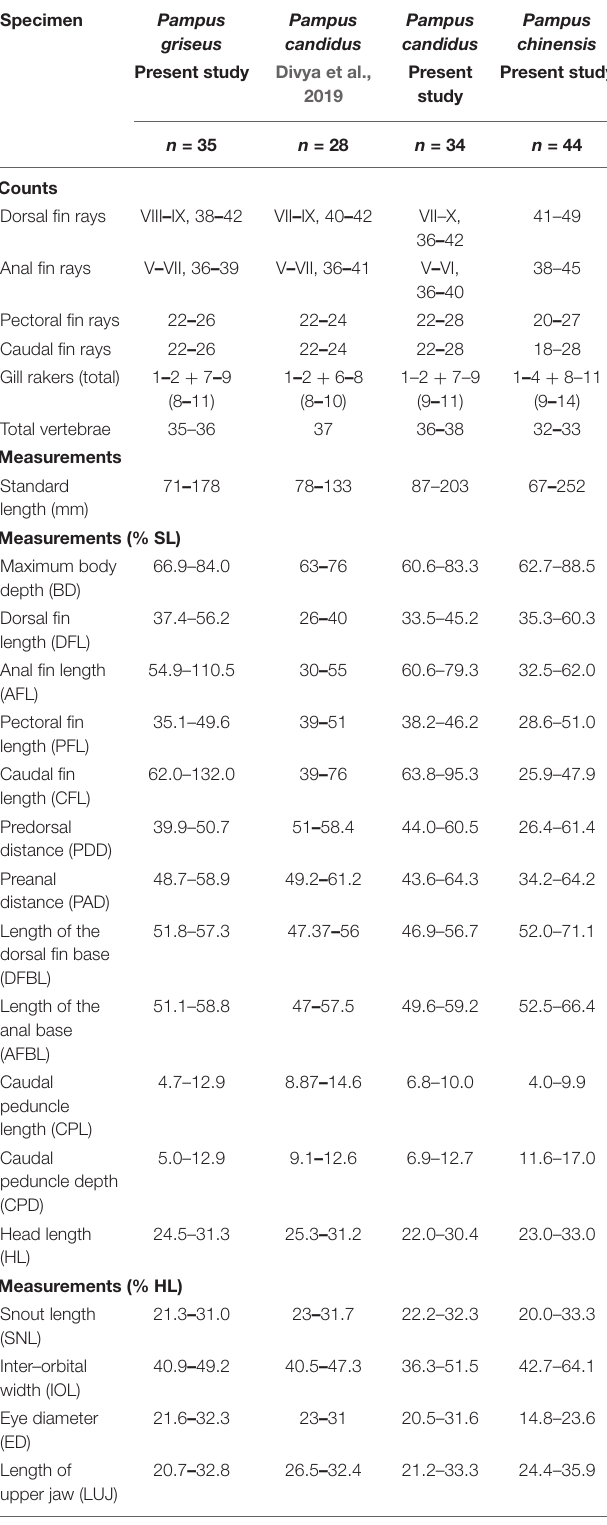
TABLE 1 | Morphometric and meristic data for Pampus griseus , Pampus candidus , and Pampus chinensis from Indian